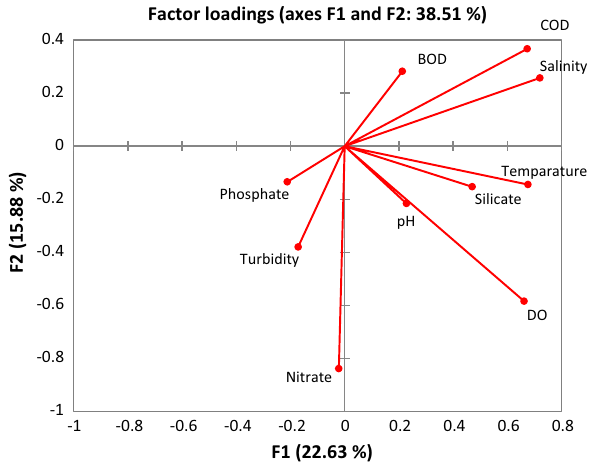
Fig. 5 Factor loading of water quality parameters after varimax rota-